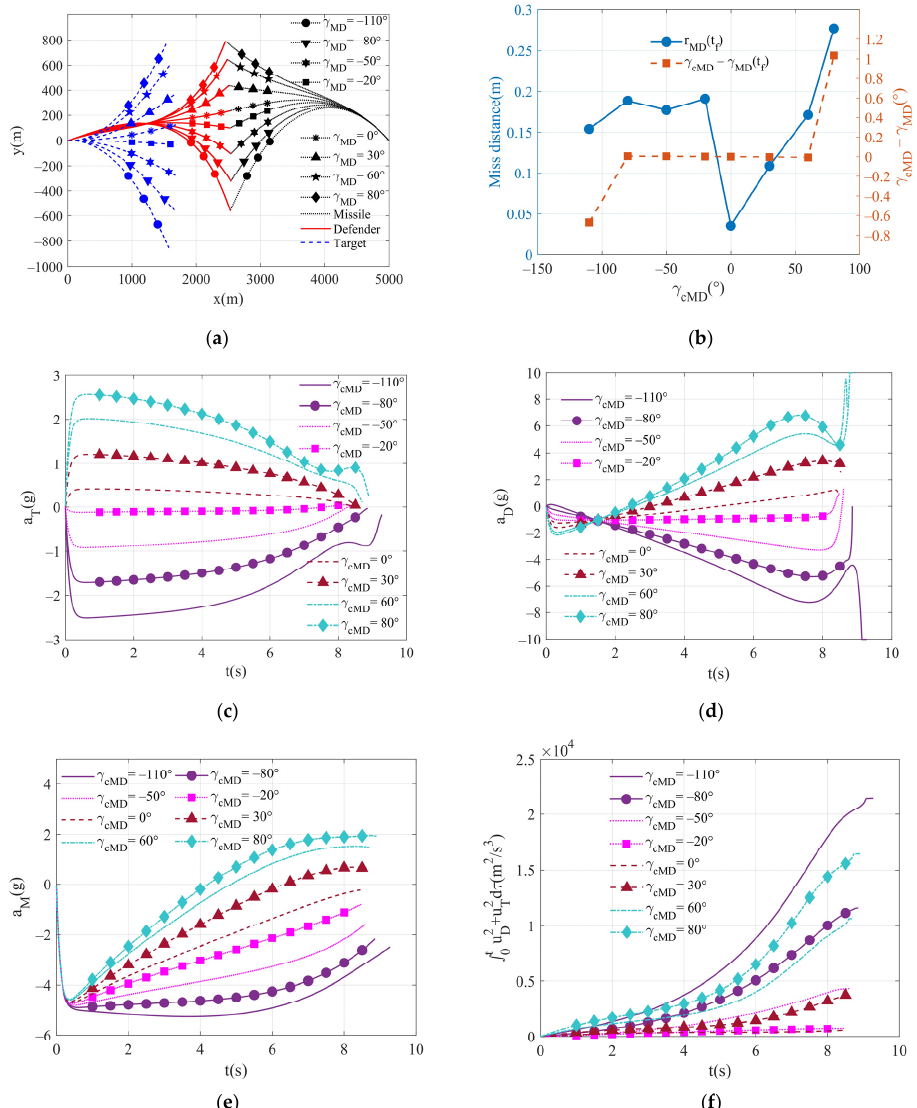
Figure 3. Comparison of performance for different terminal impact angle commands in two-way cooperation: ( a ) trajectories of entities; ( b ) the terminal miss distance and terminal impact angle; ( c ) target lateral acceleration; ( d ) defender lateral acceleration; ( e ) missile lateral acceleration; and ( f ) total control effort.